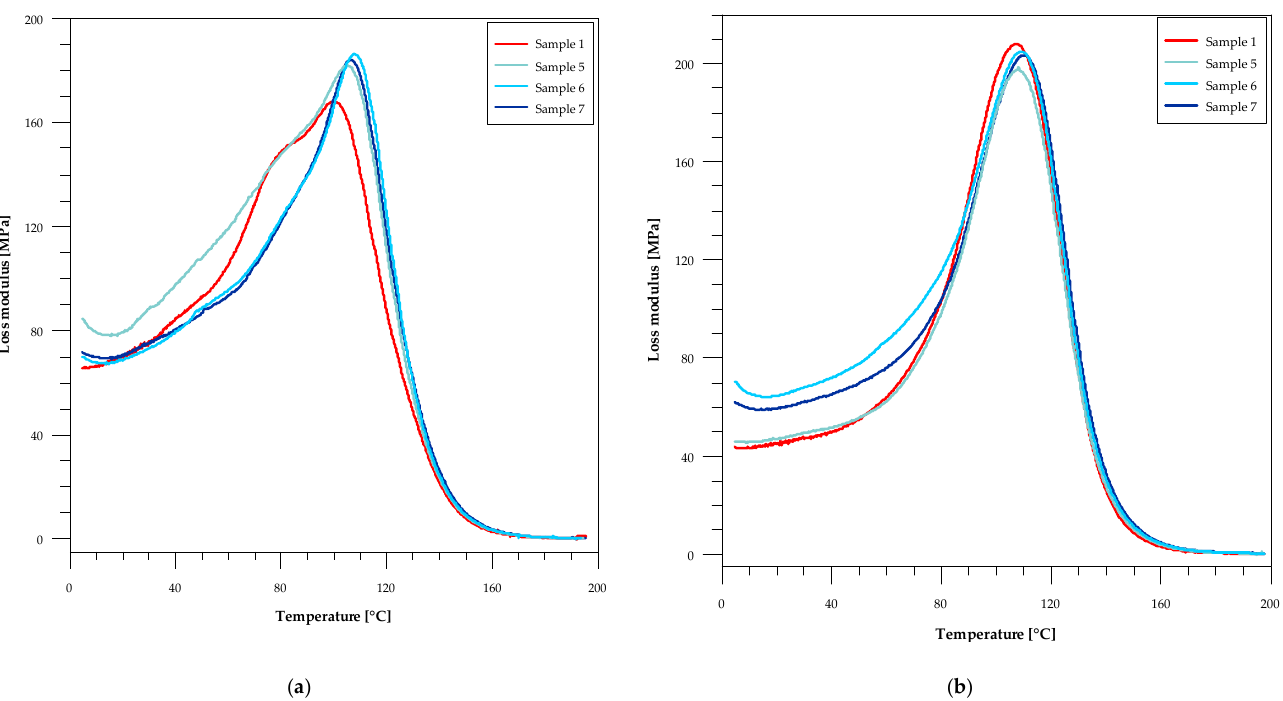
Figure 3. The temperature-dependent graph of loss modulus (E ″ ) for samples with silver nanoparticles. ( a ) Before the accelerated aging test and ( b ) after the accelerated aging test.